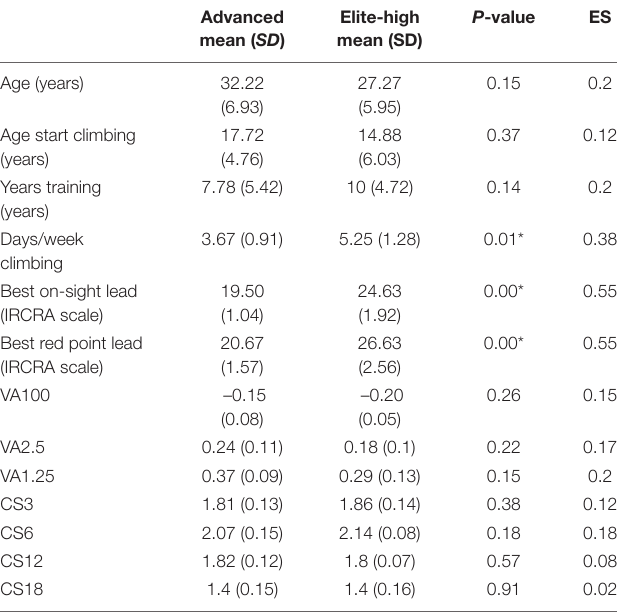
TABLE 1 | Mean (SD), p -values and Effect Size (ES) for the demographic, anthropometric and ophthalmologic